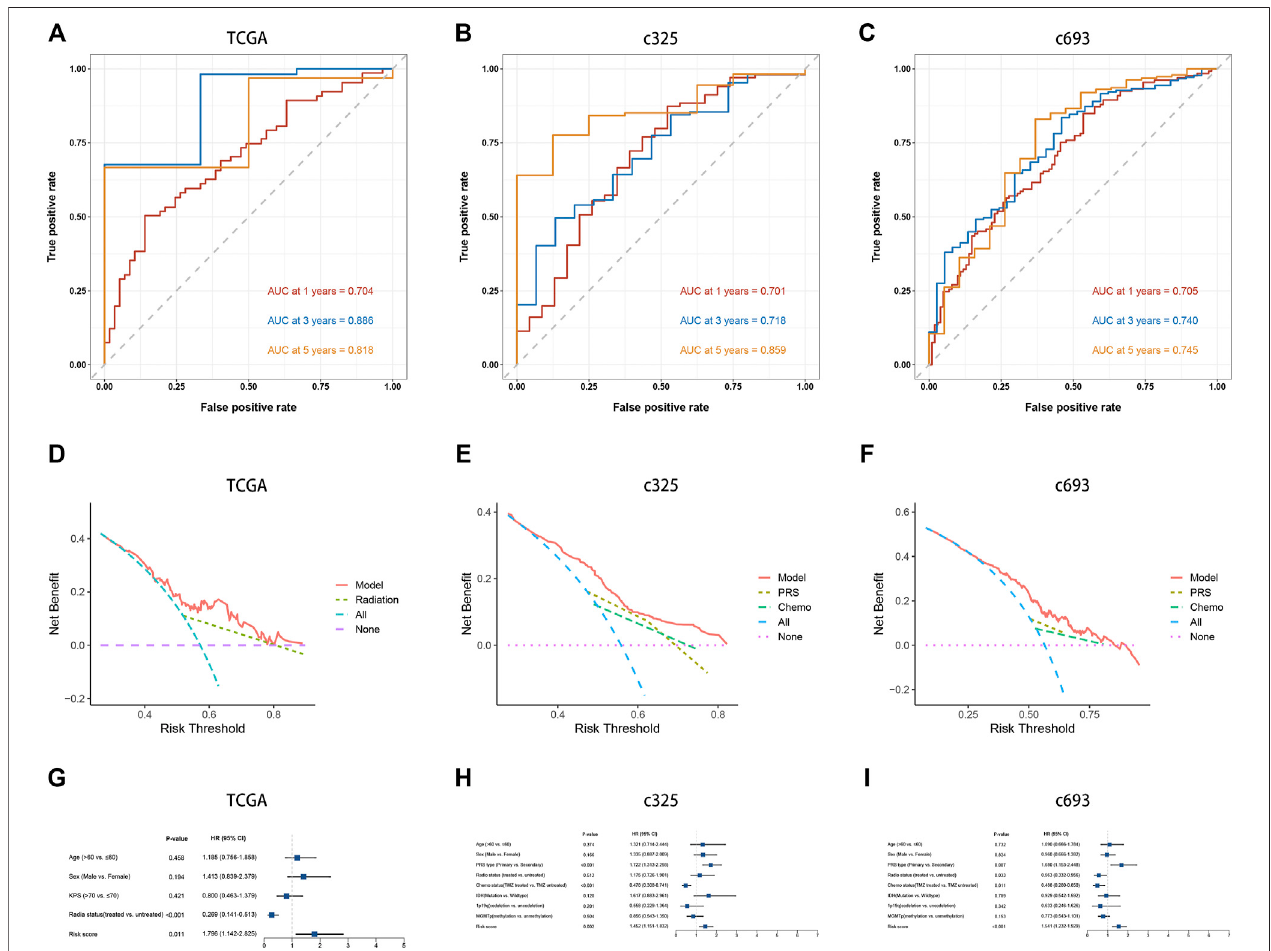
FIGURE 5 | Prediction performance and independence of the PRLS. (A – C) Time-dependent receiver operating characteristic curve (ROC) analysis for predicting overall survival (OS) at 1-, 3-, and 5-years (D – F) Decision curve analysis (DCA) curves to evaluate the clinical utility of different decision strategies, and the red line represented the PRLS. (G – H) Multivariate Cox regression analysis of the risk score in three cohorts.